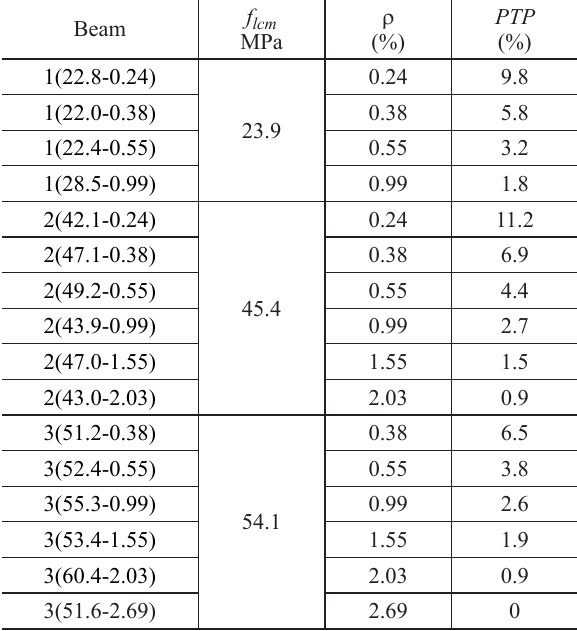
Table 2. Experimental values of PTP